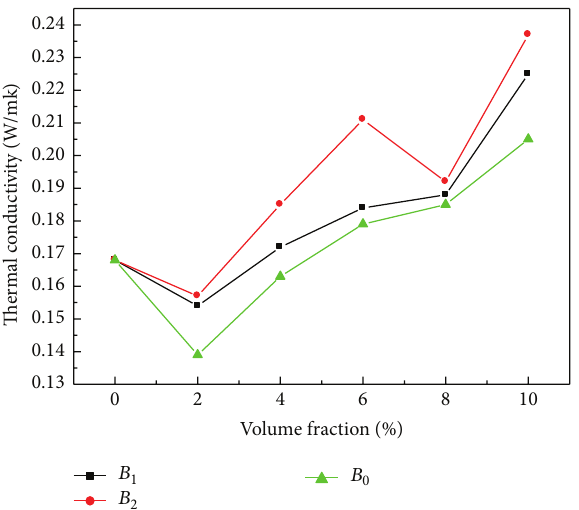
Figure 7: Impact of volume fraction on thermal conductivity of Fe 3 O 4 /MWNTs/NR composite (at 80 ∘ C test